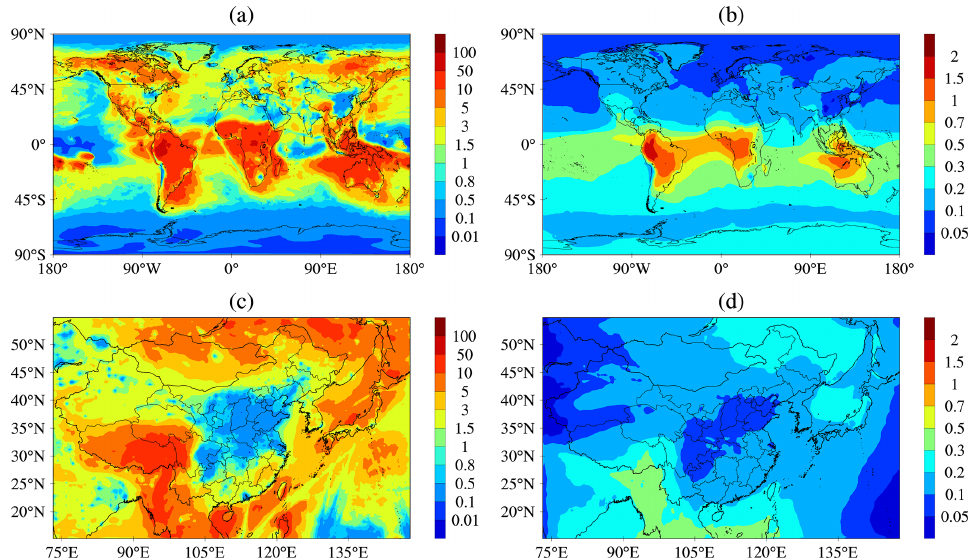
Figure 10. The ratio of LV-SOGs to H 2 SO 4 (a, c) and the ratio of LV-OAs to sulfate (b, d) that reside in SPs. Panels (a, b) is for the first domain and panels (c, d) for the second domain.